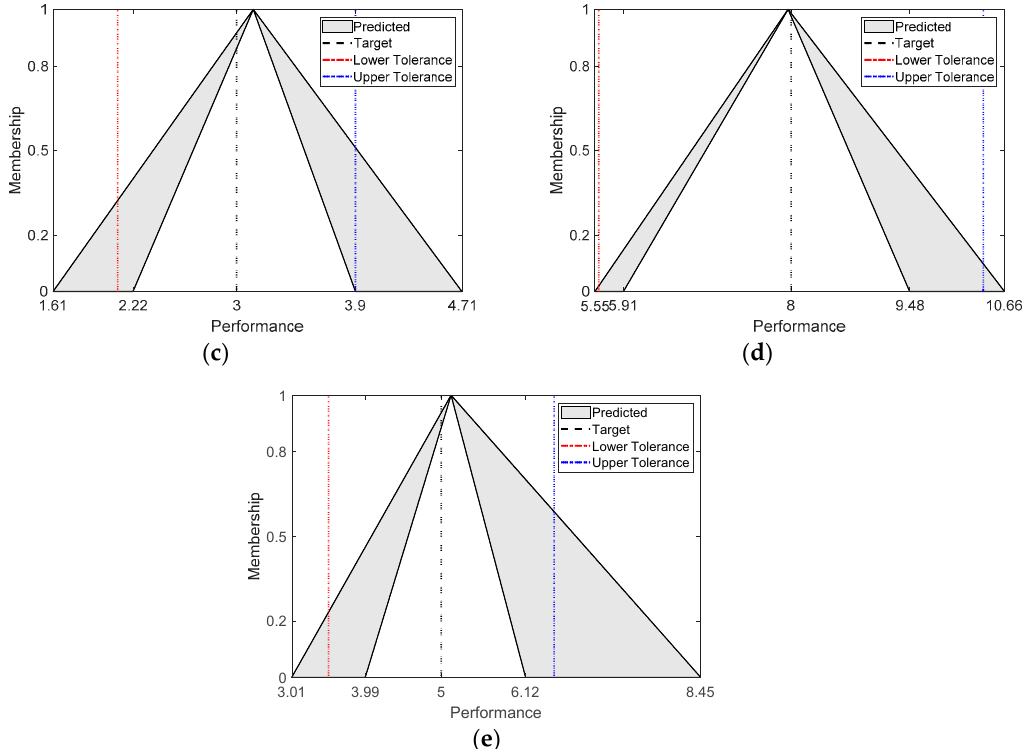
Figure 7. Details of the predictions for the 1st alternative. ( a ) 6th data point w.r.t. 1st criterion; ( b ) 6th data point w.r.t. 2nd criterion; ( c ) 5th data point w.r.t. 3rd criterion; ( d ) 6th data point w.r.t. 4th criterion and ( e ) 5th data point w.r.t. 5th criterion.